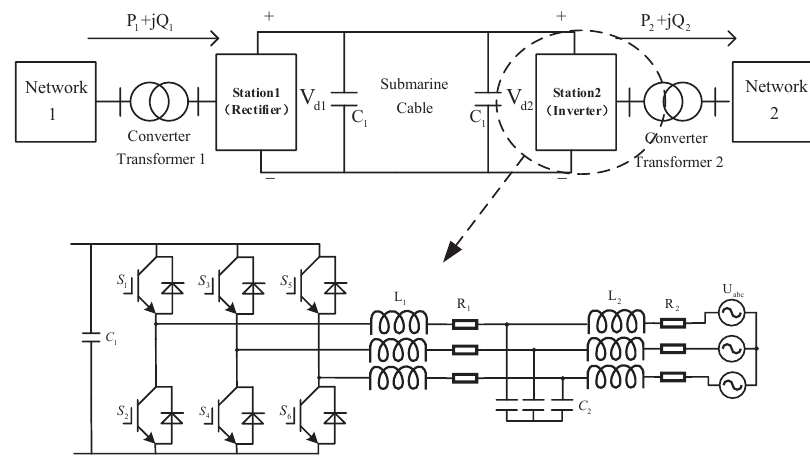
Figure 1. The structure of the VSC-HVDC transmission